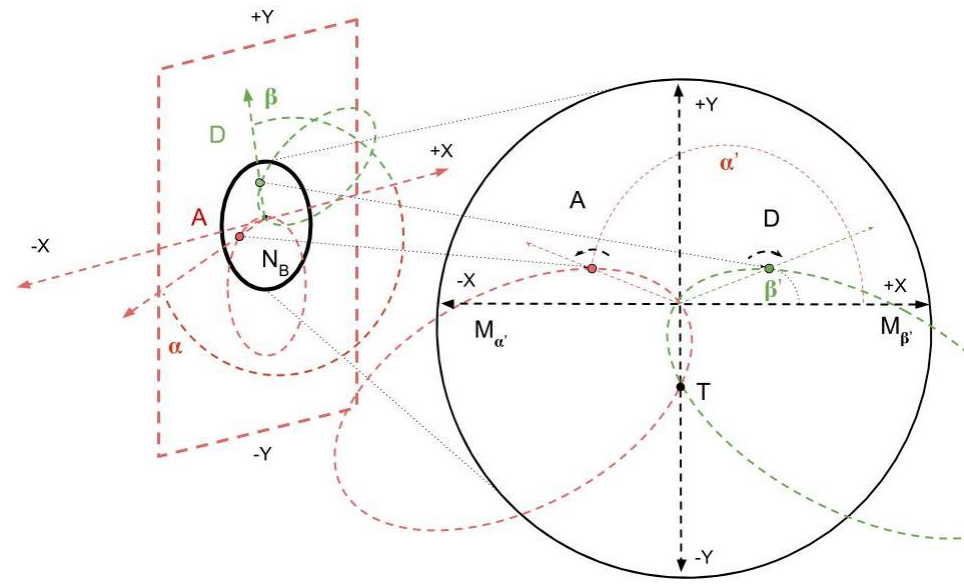
Figure 9. Balanced